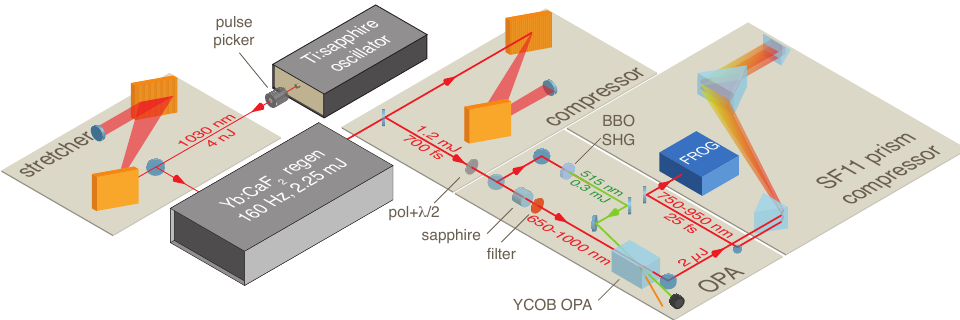
Figure 1. Schematic of the sub-picosecond pumped OPA experimental setup. pol + λ /2: half-wave plate and polarizer set; sapphire: supercontinuum generation stage; BBO SHG: second-harmonic generation stage; YCOB OPA: nonlinear amplification crystal; FROG: frequency-resolved optical gating diagnostic.